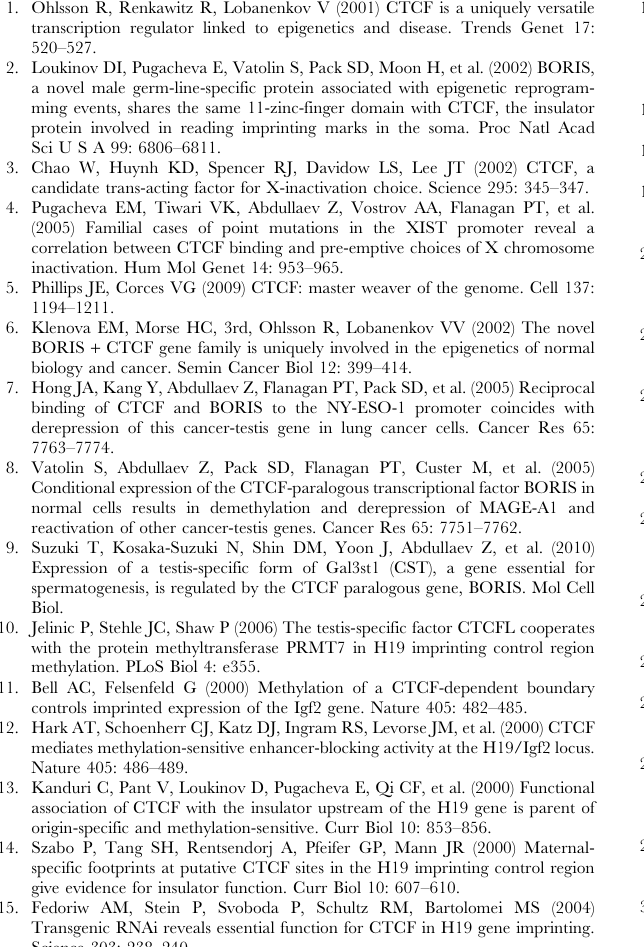
these isoforms represent less than 21% of the total amount of BORIS transcripts detected by the sf4 probe. The percent of main BORIS C3 isoform contributing to the total amount of all isoforms detecting by the sf4 Tagman probe is shown on the graph. (F). The schematic illustration of 6 dominant BORIS isoforms showing their belonging to 6 BORIS subfamilies. (G). Summary table of the 6 dominant BORIS isoforms representing the 6 subfamilies. Table S1 Table of primers used in RT-PCR and PCR assays.